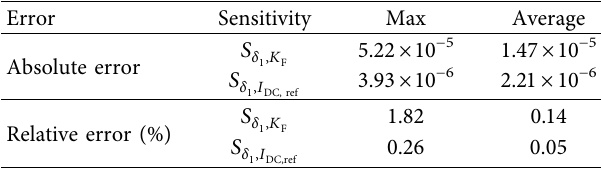
Table 1: Error analysis of the improved TS.